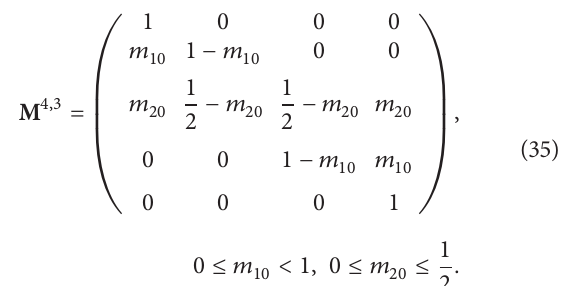
functions and the Quasi-B´ezier curves with different shape parameter 𝑚 10 and 𝑚 20 are given as